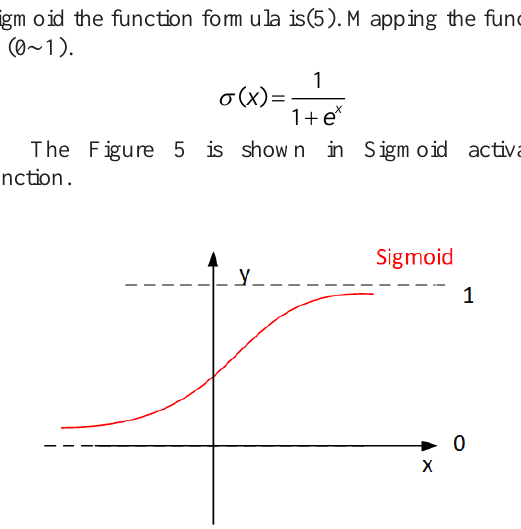
Figure 5. Sigmoid activation